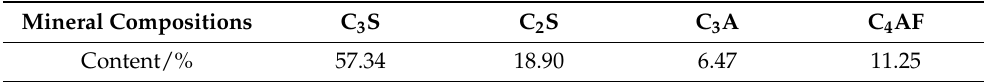
Table 2. The mineral compositions of Portland cement used in this study (wt, %).